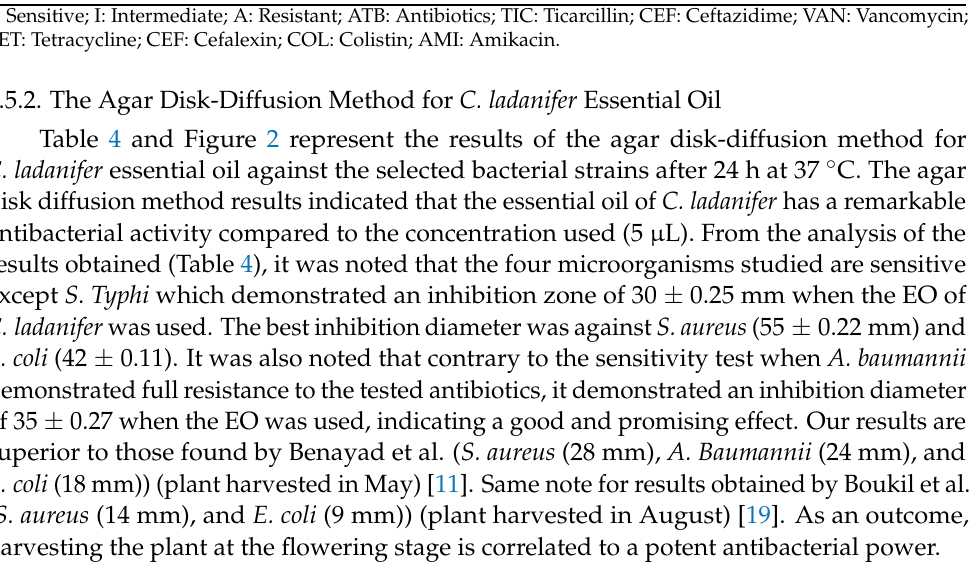
Table 4. Diameter of the inhibition zone of C. ladanifer essential oil against the four pathogenic strains. S. aureus